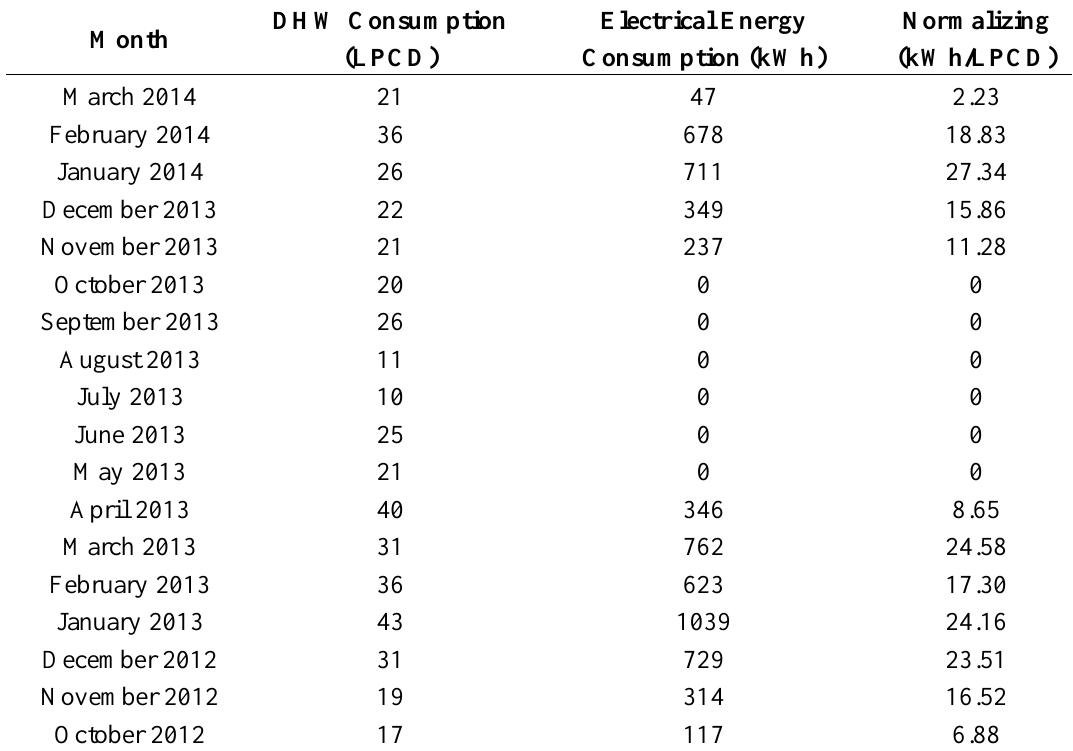
Table 7. Normalizing electrical energy consumption per DHW